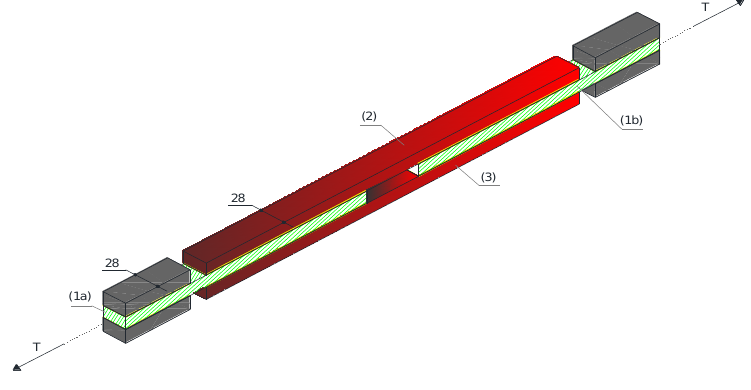
Figure 1. Joint configuration (axonometric view).